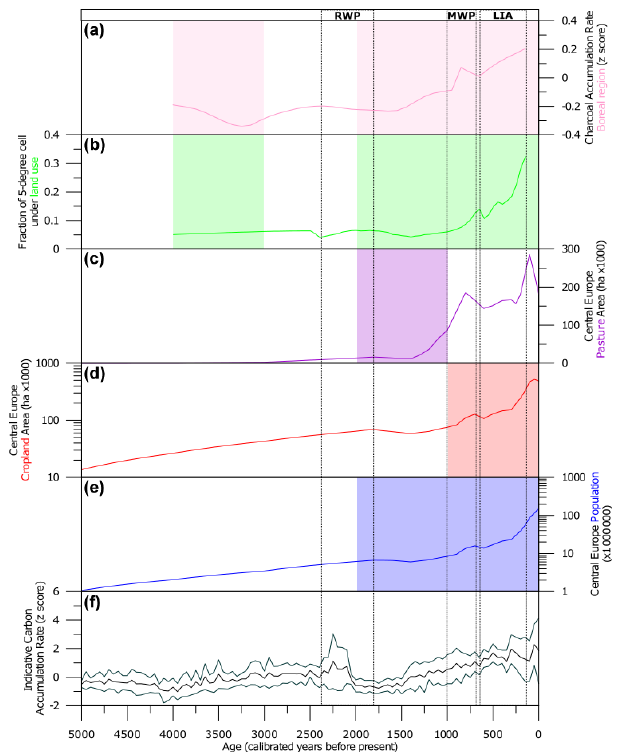
Figure 6. Comparison of the reconstructed carbon accumulation rate (CAR) for central–eastern Europe with four variables associ- ated with land use and human impact. Panels (a) – (e) display the land use variables, with charcoal deposition in panel (a) (Feurdean et al., 2020), an estimate of total land use in panel (b) (from Kaplan et al., 2011), and three respective metrics of human impact (area of pasture, cropland, and total population) in panels (c) – (e) (Gold- ewijk et al., 2017). Panel (f) displays the CAR reconstruction from this study. Coloured rectangles indicate a correlation between the variable indicated by the colour and the CAR reconstruction, as in Fig.